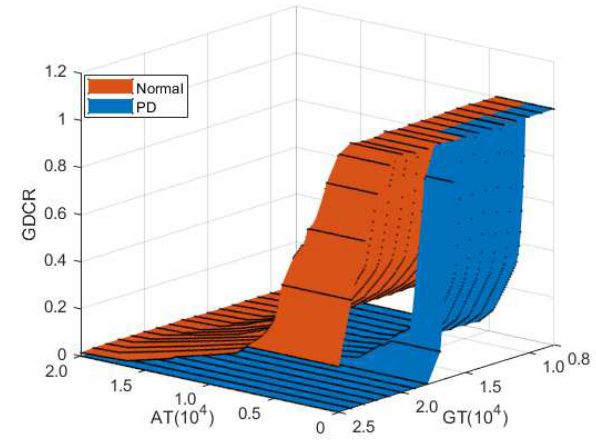
Figure 6. Experimental results of the gait disorder effect test.